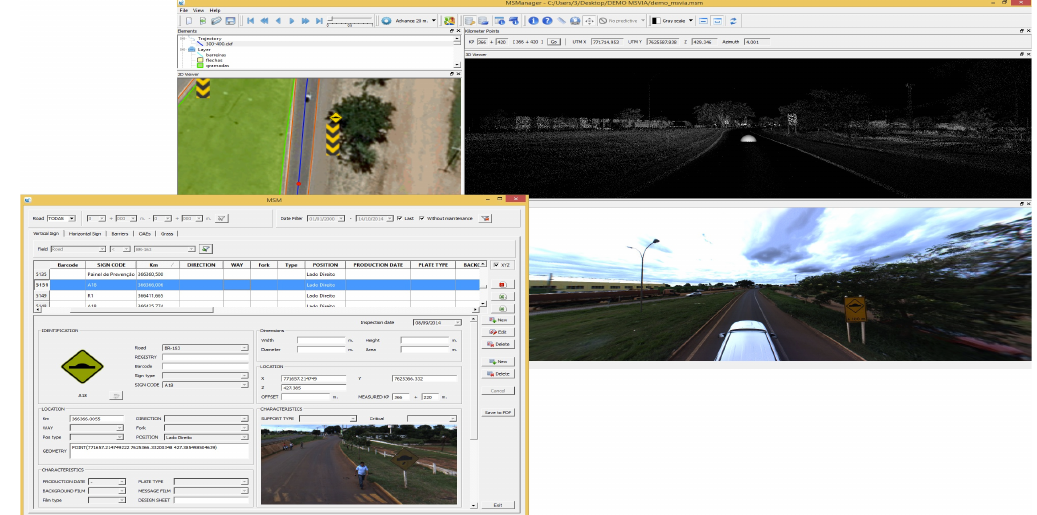
Figure 1. Interface of the point cloud based road management